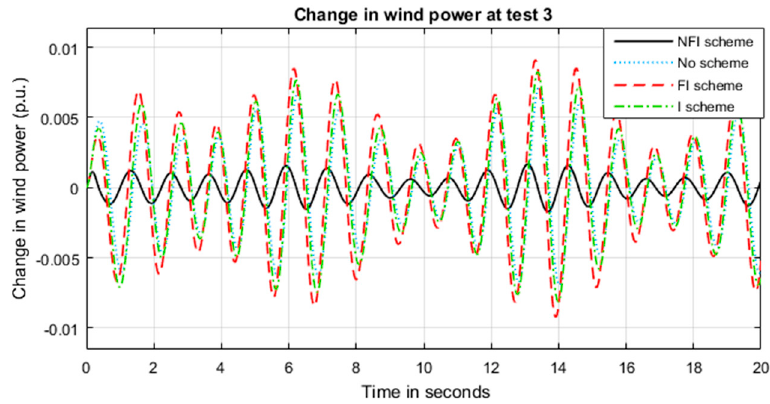
Figure 22. Change in wind power in test 3.